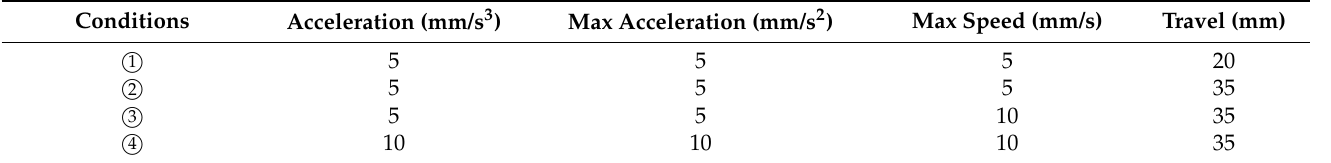
Table 1. Motion track planning